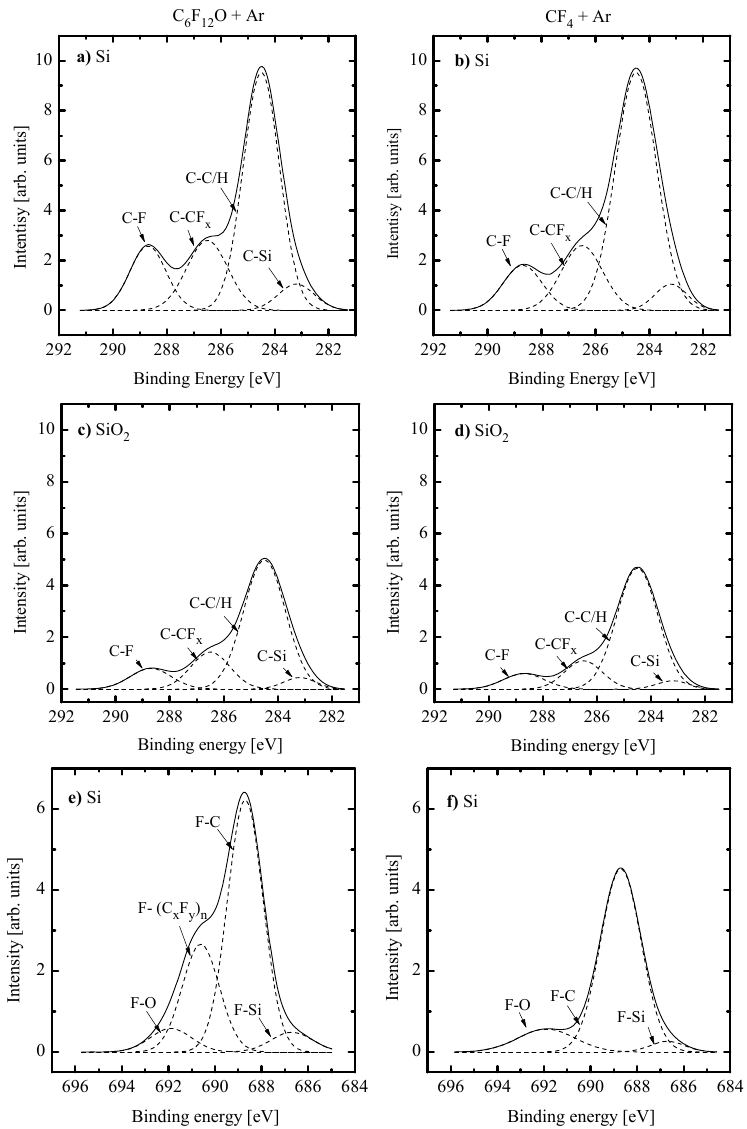
Figure 3. C(1s) ( a – d ) and F(1s) ( e , f ) XPS spectra for Si ( a , b , e , f ) and SiO 2 ( c , d ) surfaces etched in 50% C 6 F 12 O + 50% Ar ( a , c , e ) and 50% CF 4 + 50% Ar ( b , d , f ) plasmas. Processing condition are (cid:1849) = 400 W, (cid:1868) = 8